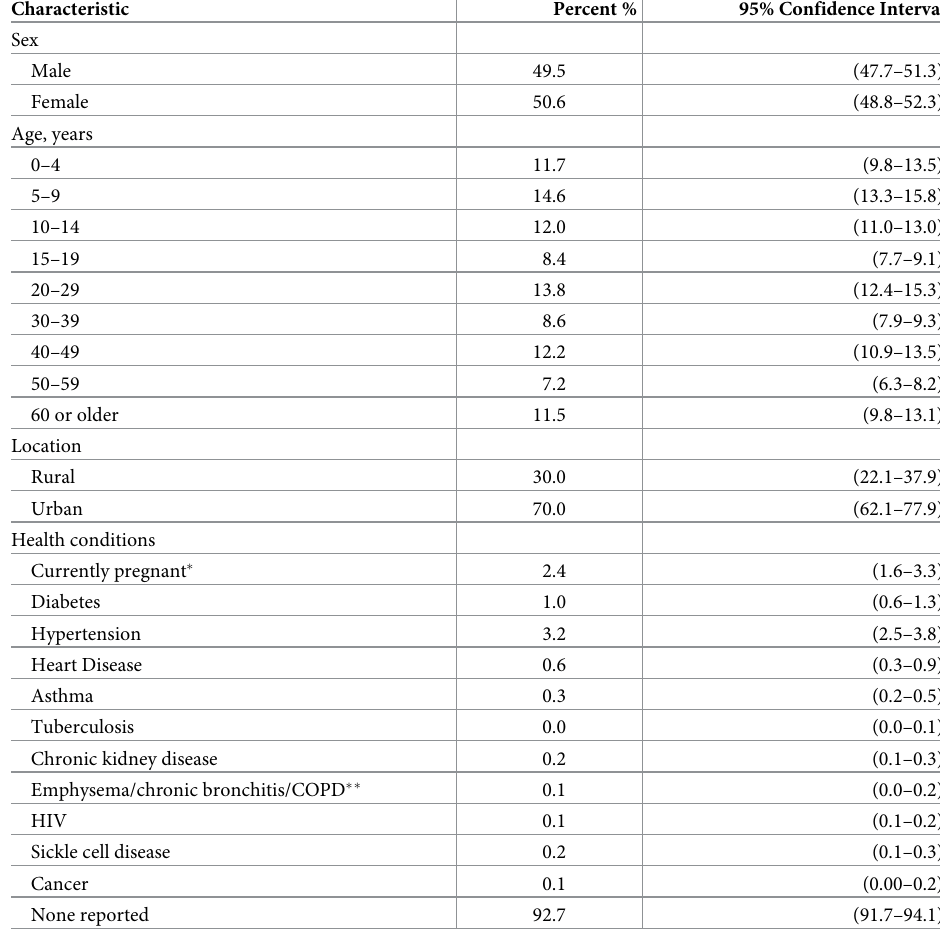
Table 1. Weighted distribution of survey participant demographic characteristics (n = 11,015), Nigeria, October